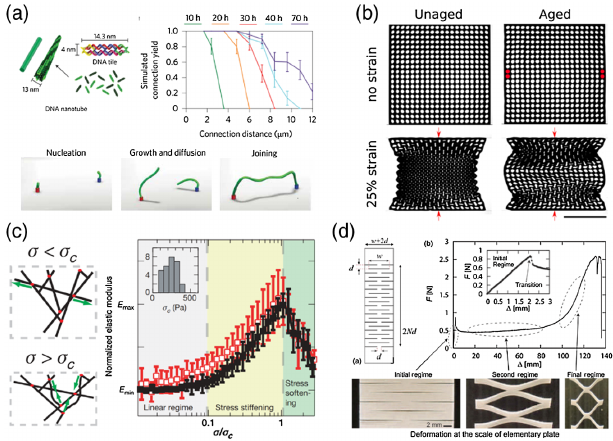
FIG. 7. Experimental networks exhibiting components of learning and nonlinear elasticity. (a) Synthetic DNA origami nanotubes forming connections up to certain distance, as our chosen f ð r Þ (adapted from Ref. [20]). (b) EVA foam-based network changes nonlinear elastic properties when aged under strain (adapted from Ref. [38]). (c) Reversible stress softening in actin networks, a natural form of elastic nonlinearity in grown networks (adapted from Ref. [39]). (d) Kirigami structure with ξ ≈ 1 nonlinear elasticity (adapted from Ref.